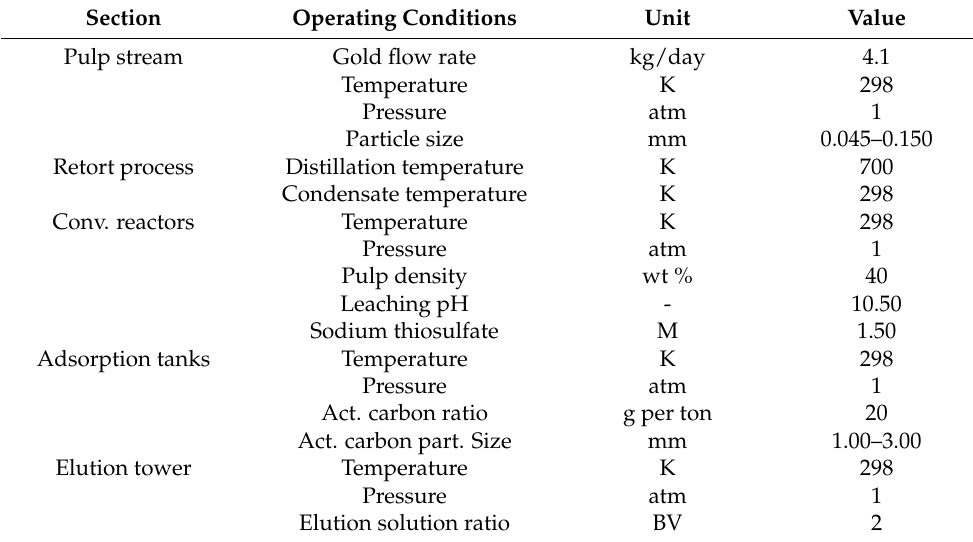
Table 4. Hydrometallurgical process simulation conditions when the leaching agent is sodium thiosulfate.